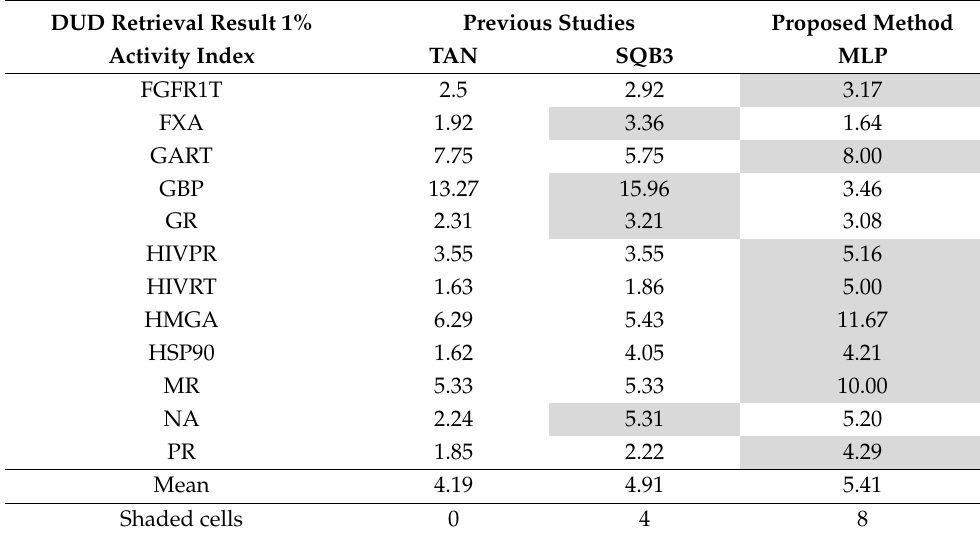
Table 14. Top 1% retrieval results for DUD dataset.